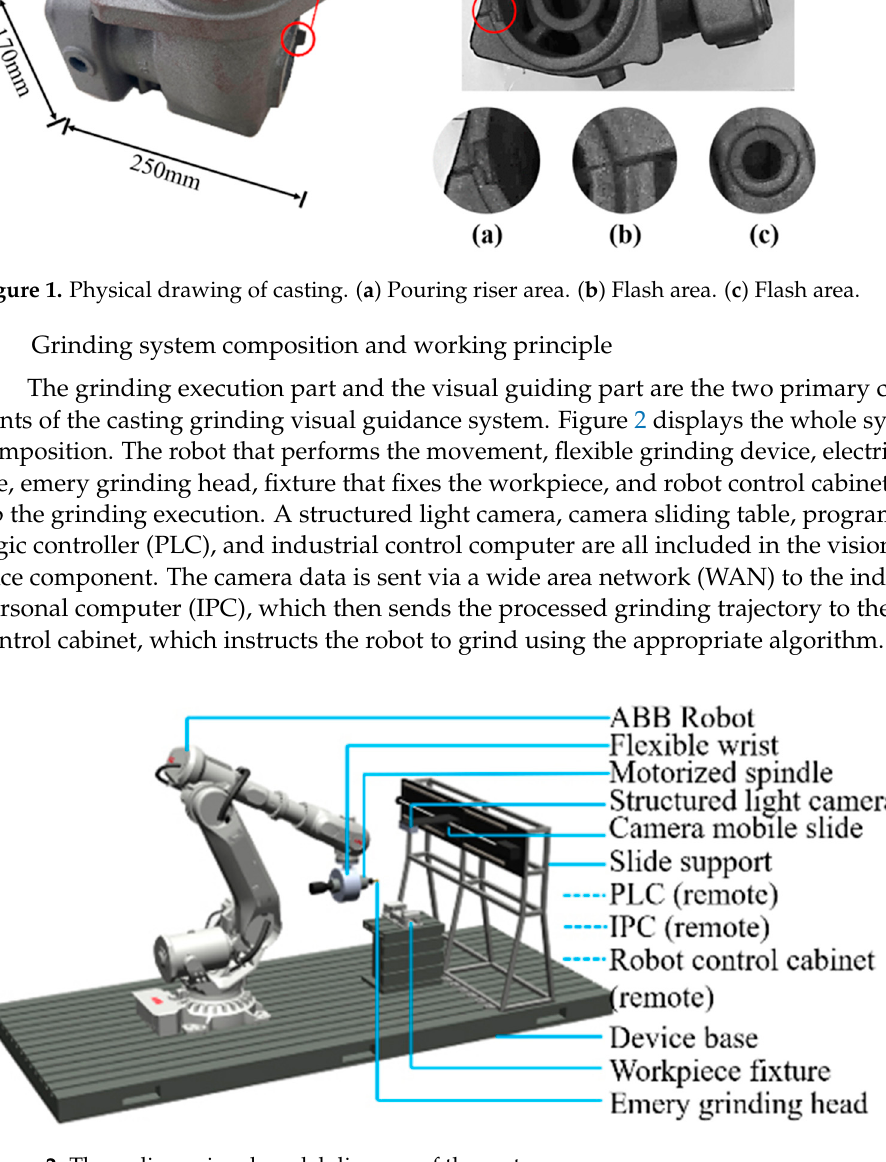
Figure 2. Three-dimensional model diagram of the system.